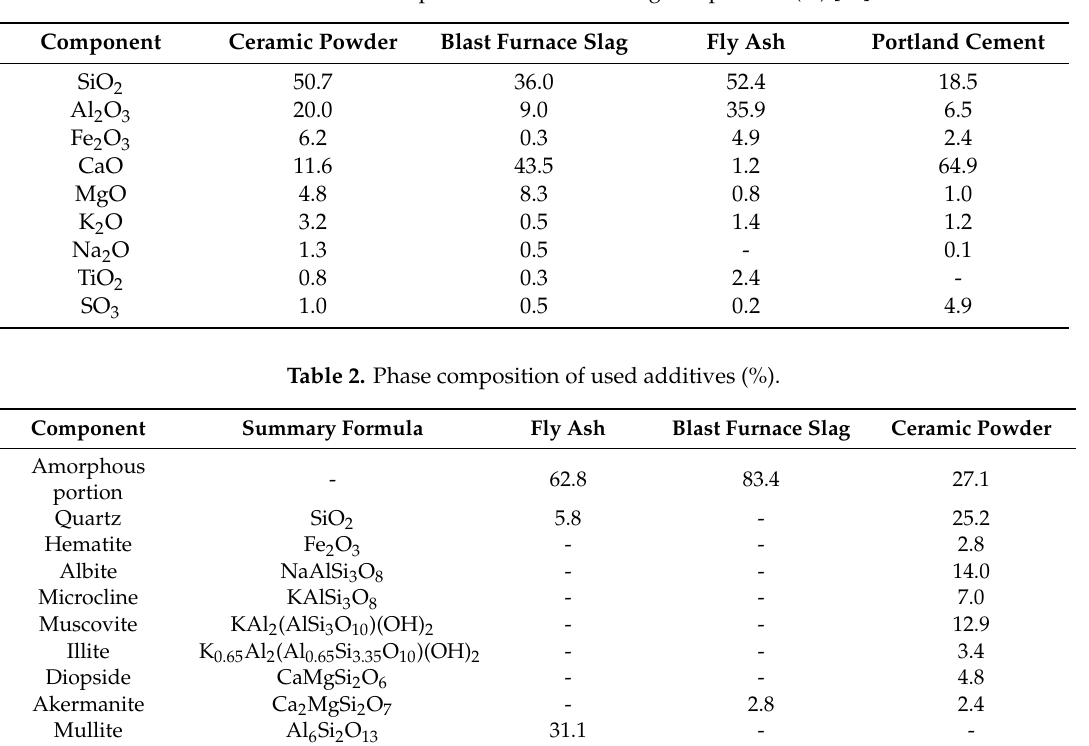
Table 1. Chemical composition of used binding components (%) [38].